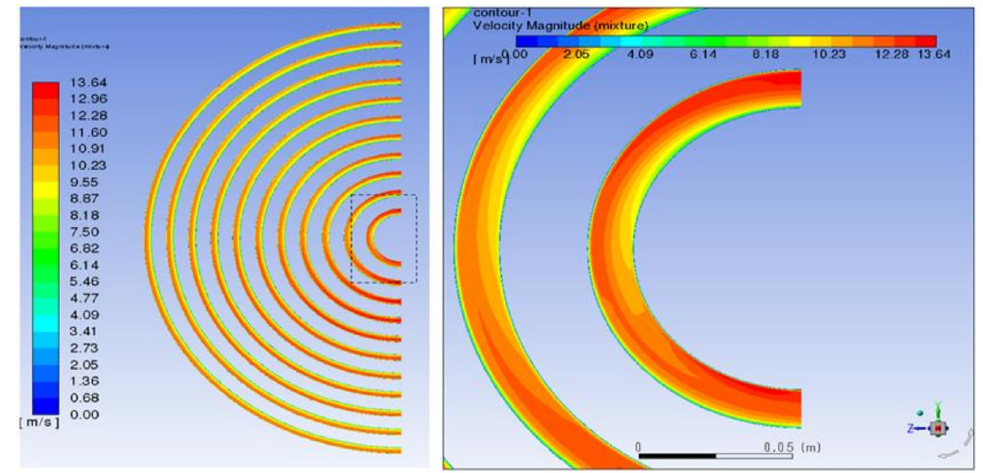
Figure 15. Velocity distribution in the bend area of heat exchange.